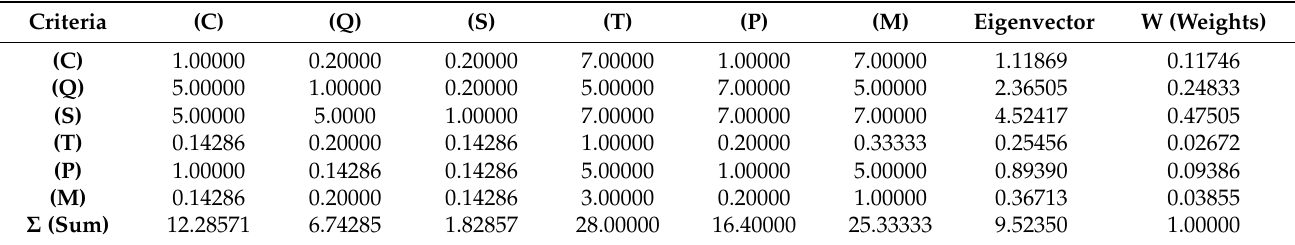
Table 6. Judgment matrix (SCM manager).